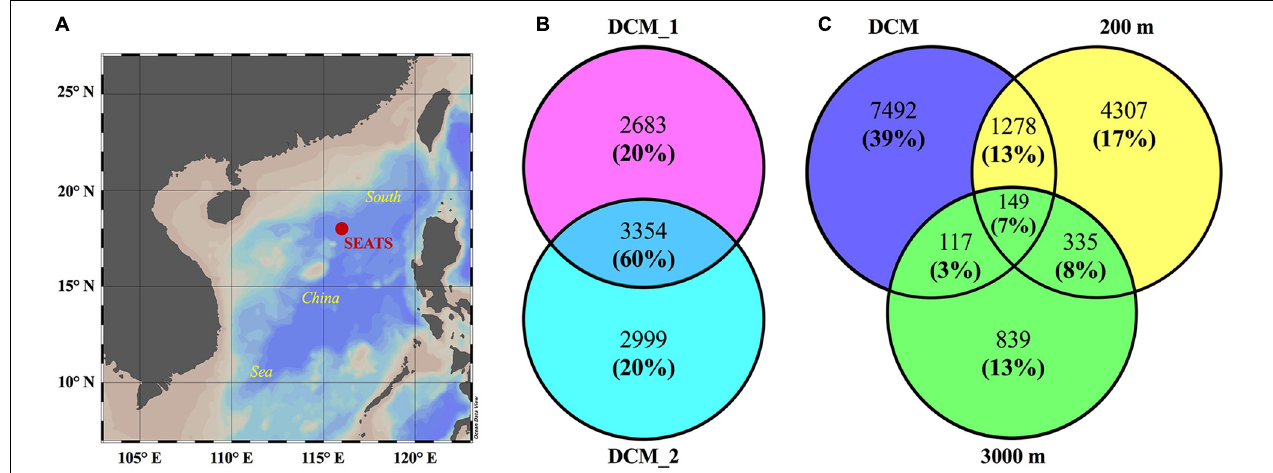
FIGURE 1 | Numbers of proteins in the exoproteomes from the water layers at the deep chlorophyll maximum (DCM), 200 and 3,000 m at SEATS station in the South China Sea (SCS). The map (A) shows the position of sampling site. Venn diagrams show the number and relative abundance of exoproteomes between two biological replicates from the DCM (B) and between different water layers (C) . In Venn diagrams, numbers without and in brackets show the proteins counts of each part and their proportions of total relative abundance of four exoproteomes, respectively. Exoproteome from the DCM shown in (C) include all the non-redundant proteins identified in the two biological